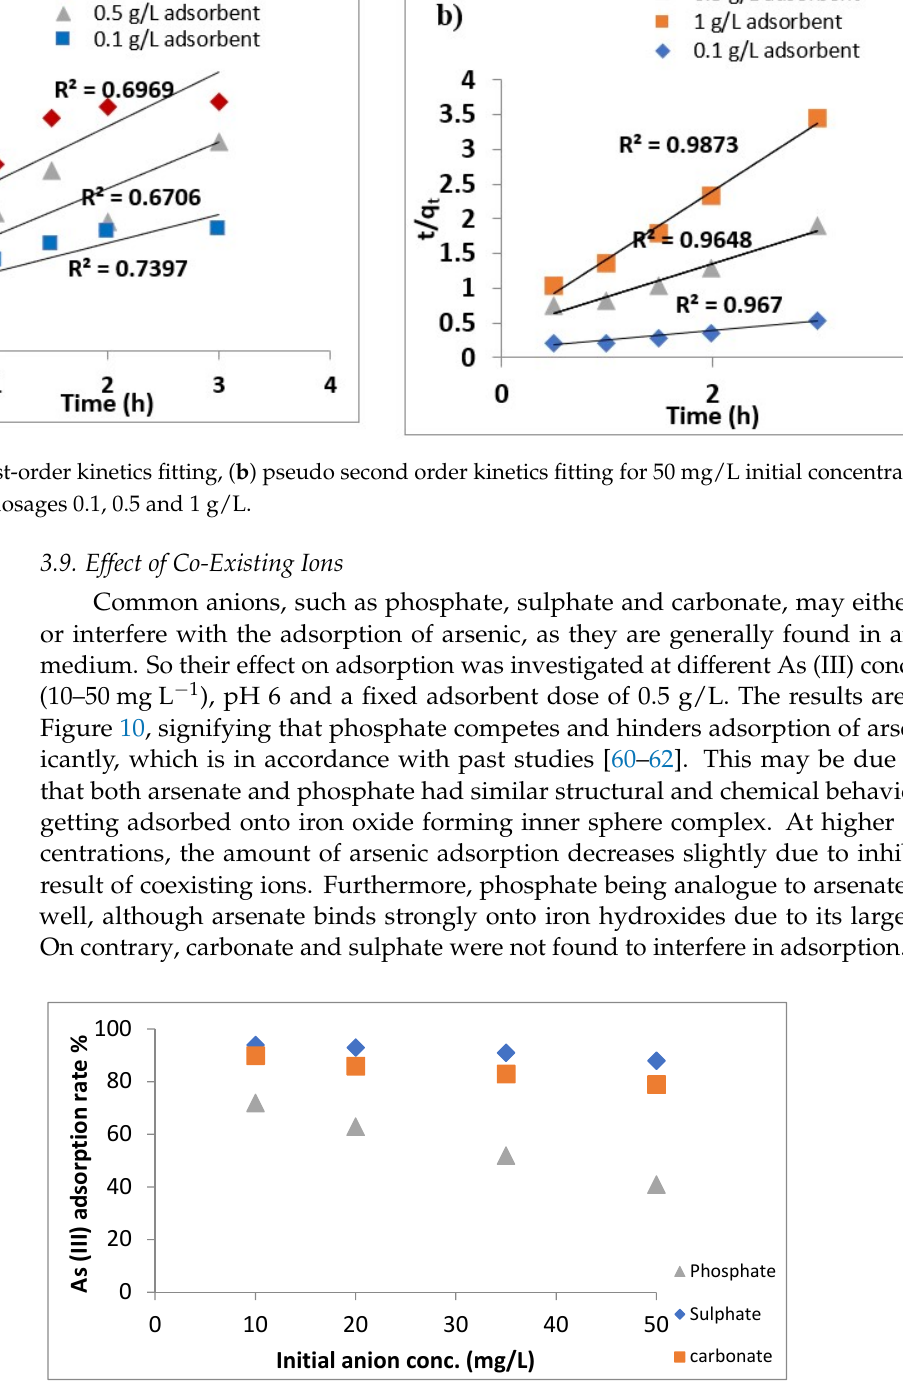
Figure 10. Effect of coexisting ions (PO 43 − , SO 42 − and CO 32 − ) on As (III) adsorption.